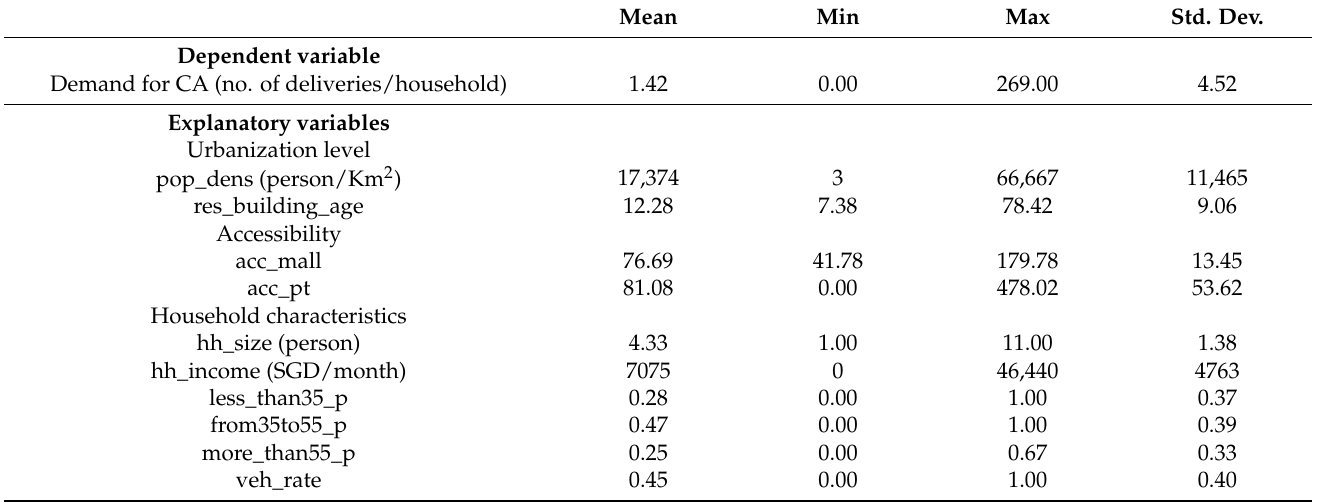
Table 2. Summary of